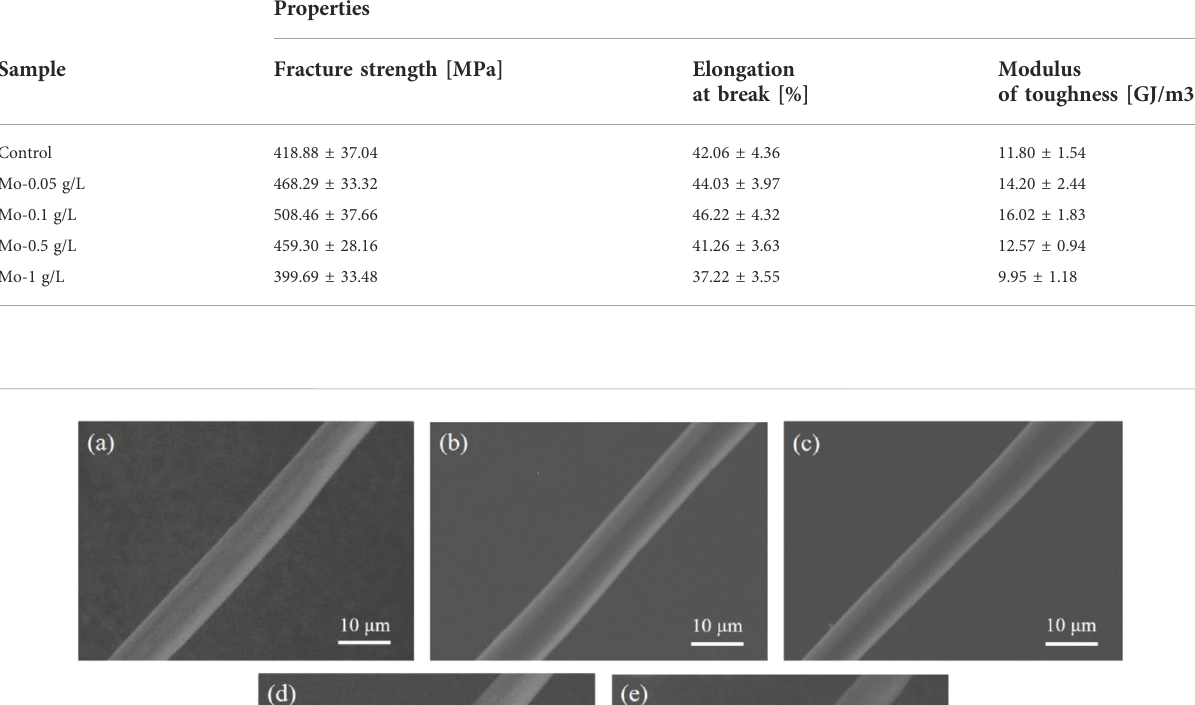
TABLE 1 Mechanical properties of the obtained silk